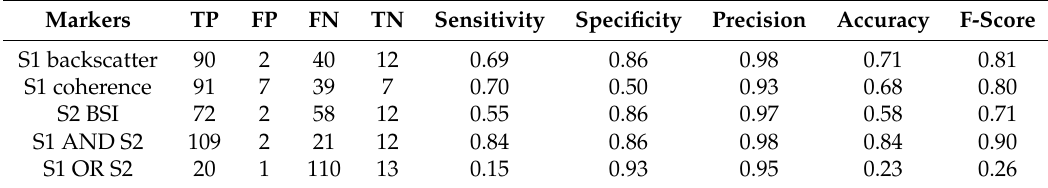
Table 11. Marked declared grasslands fields with S1 and S2, S1 or S2 among the surveyed parcels (TP: True Positive, FP: False Positive, FN: False Negative, TN:True